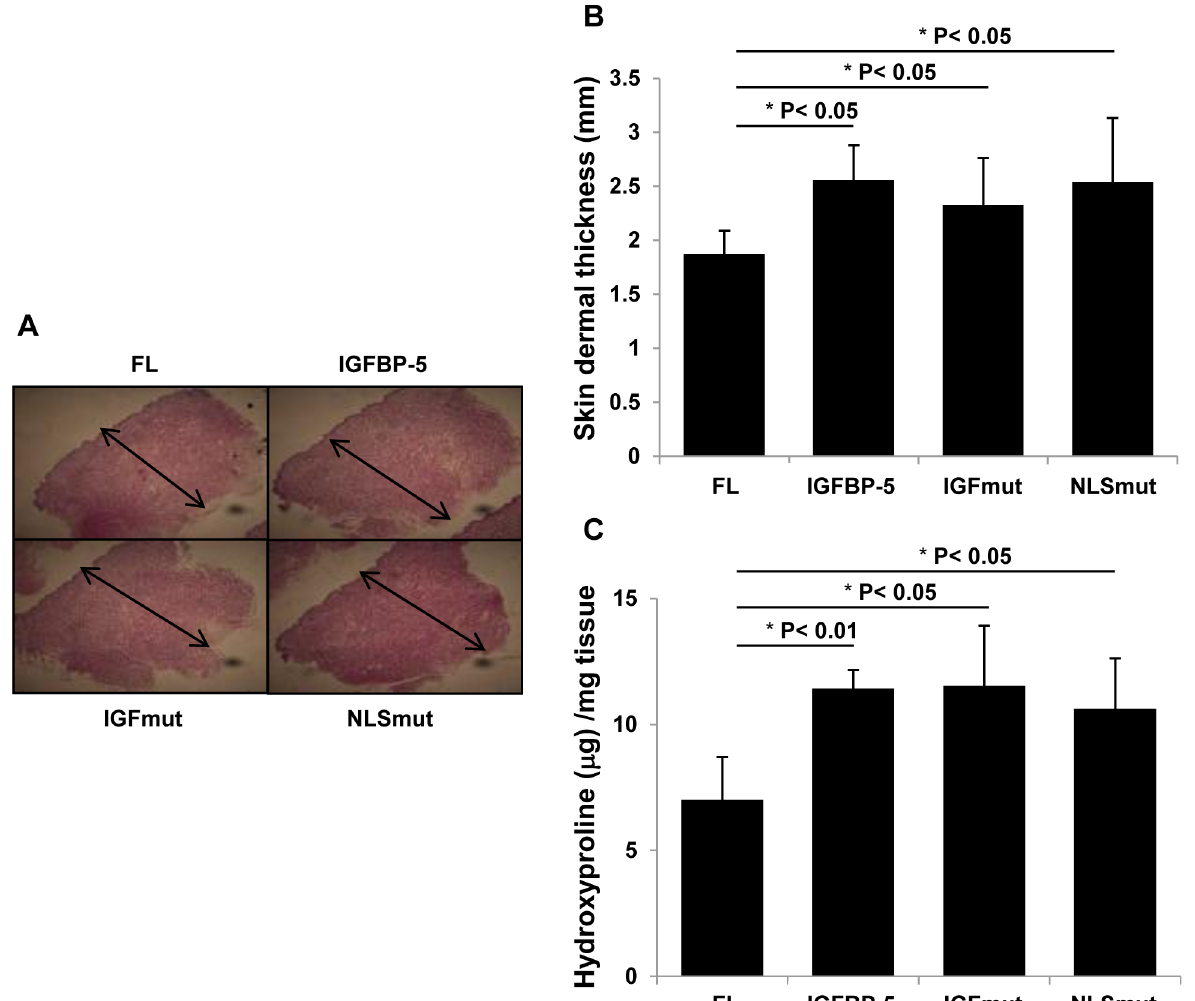
Fig 3. Mutant IGFBP-5 is pro-fibrotic ex vivo in human skin. Human skin from four different donors was injected with the indicated IGFBP-5 expressing adenoviruses and maintained in organ culture for 10 days. (A) Skin was harvested and examined histologically. (B) Dermal thickness was measured in human skin explants. (C) ECM was quantified using hydroxyproline assay. Data in (B) and (C) represent mean and standard